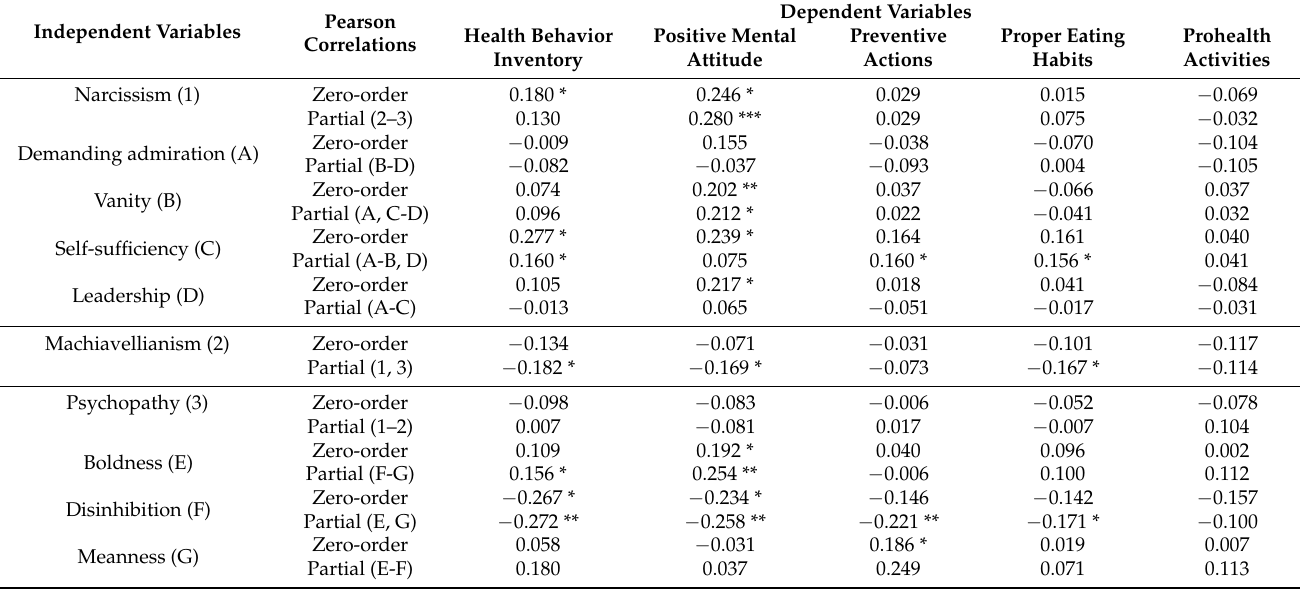
Table 2. Intensity of health behaviors vs. the Dark Triad traits and their components (zero-order and partial correlations). Independent